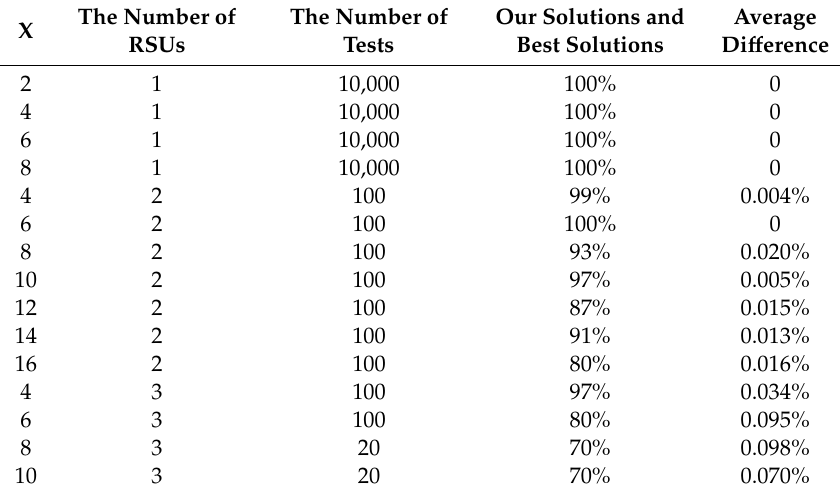
Table 2. The comparison between our solutions and the best solutions.